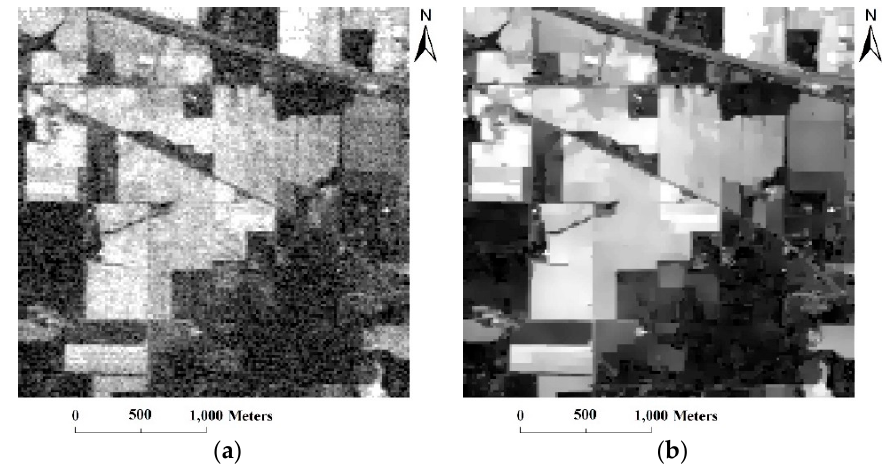
Figure 2. Example of the hyperspectral anisotropic diffusion PDE process for the Indian Pines data set: ( a ) original noisy band 185; and ( b ) diffused result.